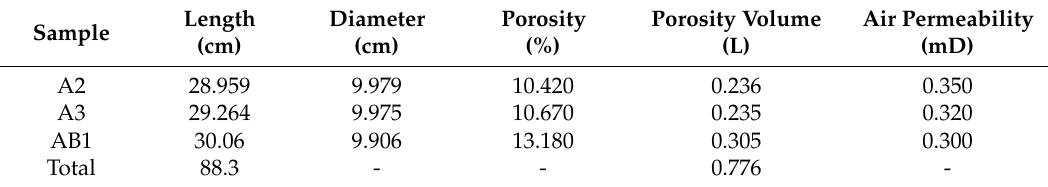
Table 2. The parameters of core samples used in the experiments.